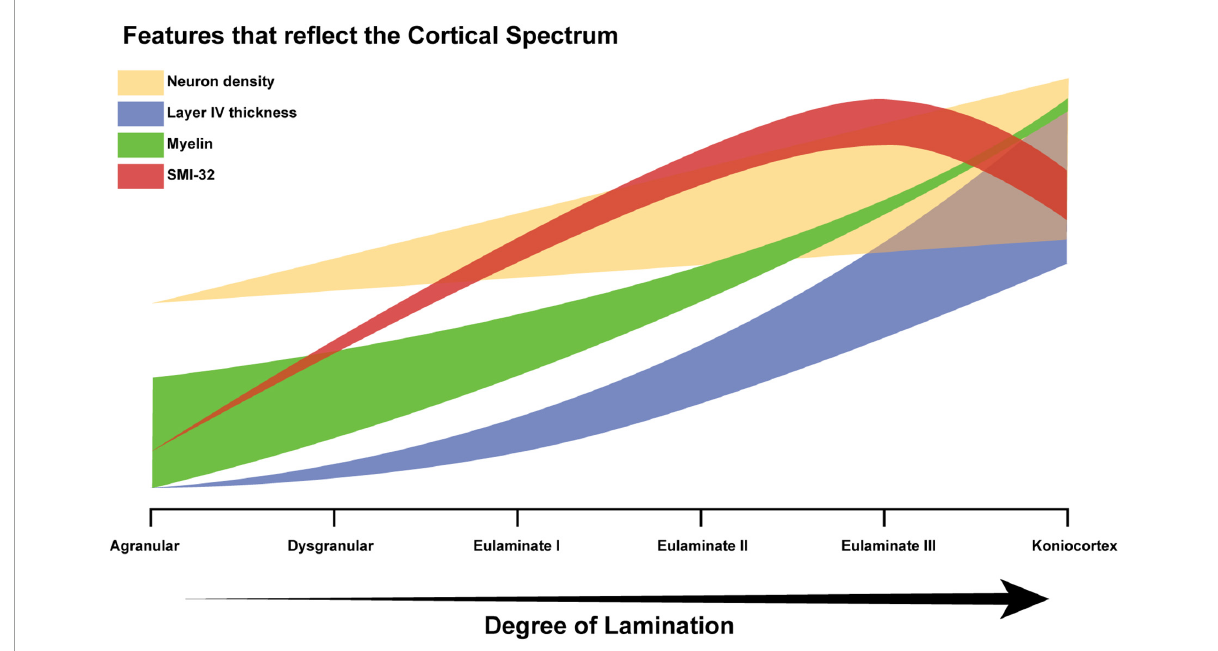
FIGURE9 Schematic diagram of the cortical spectrum. The X-axis represents increasing degree of lamination, which corresponds to the traversal from agranular areas to koniocortical areas. The Y-axis represents the relative magnitudes of the features that serve as partial proxies of degree of lamination (arbitrary units). The thick translucent bar surrounding each plot corresponds to the variability in the feature. For example, the green bar corresponding to the variability in myelin density is initially thick and then becomes thinner, because a few agranular areas show high myelin, whereas, eulaminate areas are always well-myelinated. Limbic areas generally have low myelin content, but cortical myelin shows not only the intrinsic myelin of an area but also terminations from pathways from other structures that may be